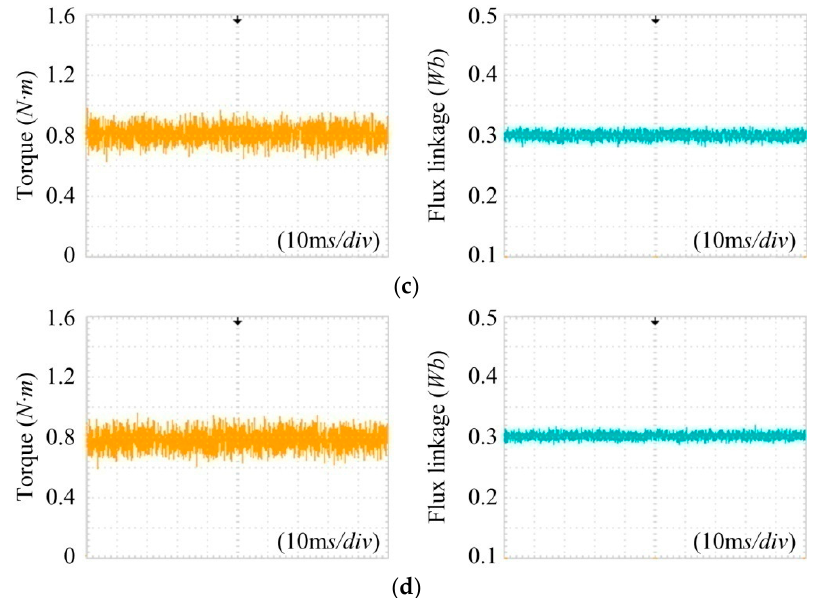
Figure 12. Experimental torque and flux linkage of the PMSM when using: ( a ) CDTC; ( b ) DDTC; ( c ) SVM-DTC; ( d ) CVM-DTC.